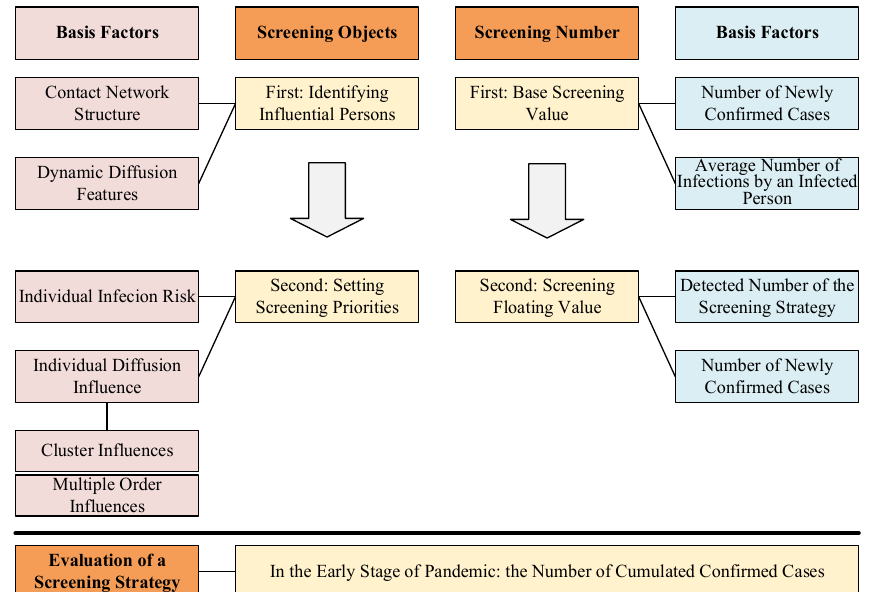
Figure 1. Illustration of the proposed strategy formulation framework (SFF). SFF is used to ensure the screening objects and screening number, and they all include two steps. The red column on the left illustrates the basis factors for identifying and selecting the screening objects. The blue column on the right illustrates the basis factors for setting the screening number. The bottom box illustrates the evaluation metric of screening strategy.